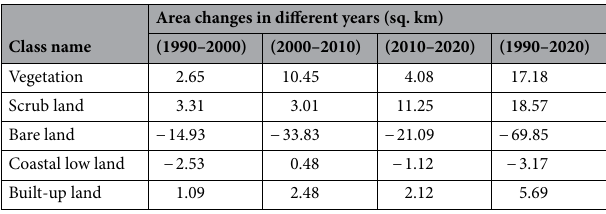
Table 4. Changes in the area of Farasan Island in different periods.